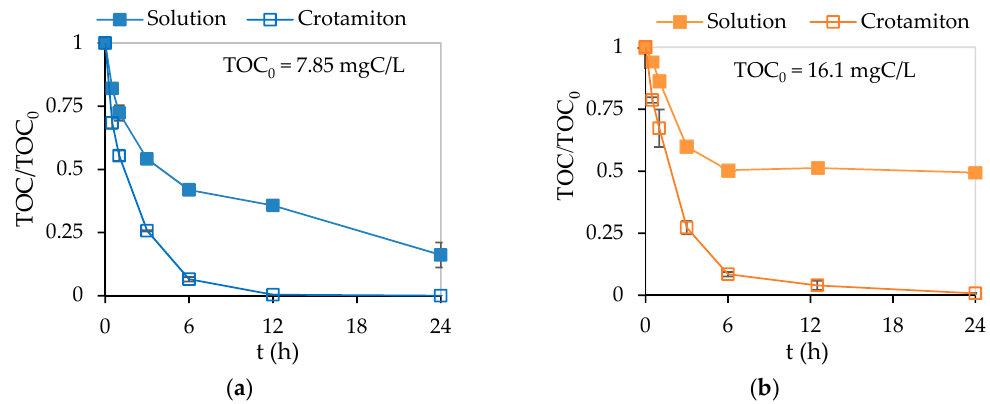
Figure 6. Removal of TOC in the solutions and the TOC derived from the residual crotamiton during the treatment by the HSZ-385/P25 composite sheet with ultraviolet irradiation in ultrapure water ( a ) and RO concentrate ( b ). Results are means ± standard deviations ( n = 2).